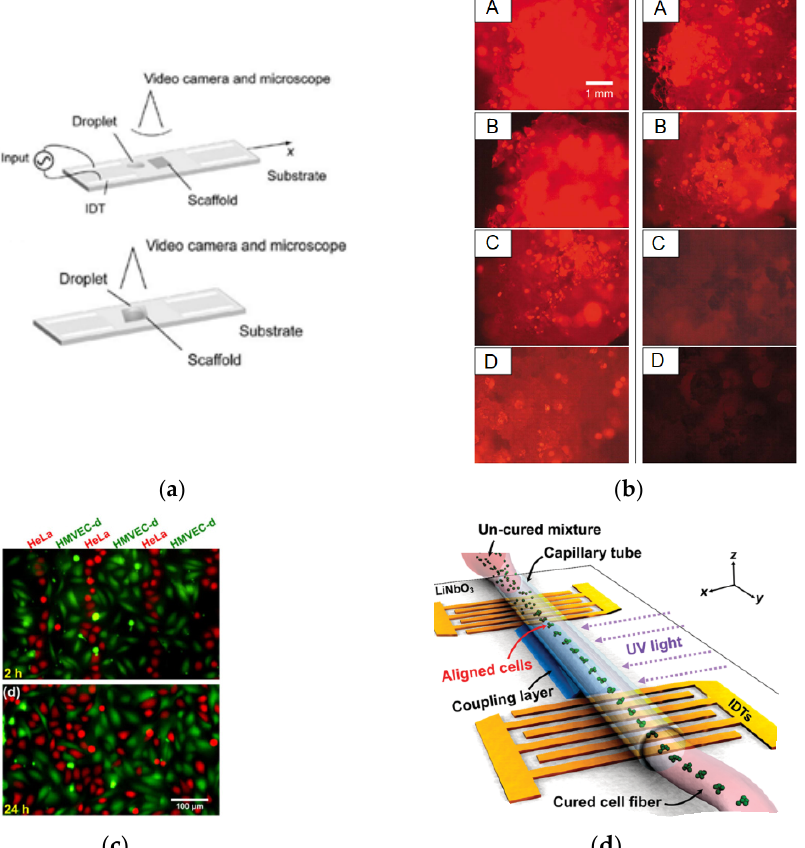
Figure 8. ( a ) Scheme of the experimental cell seeding setup by SAW [46]. ( b ) Comparison between SAW-driven seeding (10 s) and static seeding (30 min) after the cells penetrate the scaffold [47]. ( c ) SAW-based sequential cell seeding with the co-culture results: HMVEC-d cells (green fluorescent) and HeLa cells (red fluorescent) [48]. ( d ) Schematic representation of the whole process in perpendicular orientation for the production of patterned cell fibres using SAW [49]. Images reproduced with permission from references. [46–49].